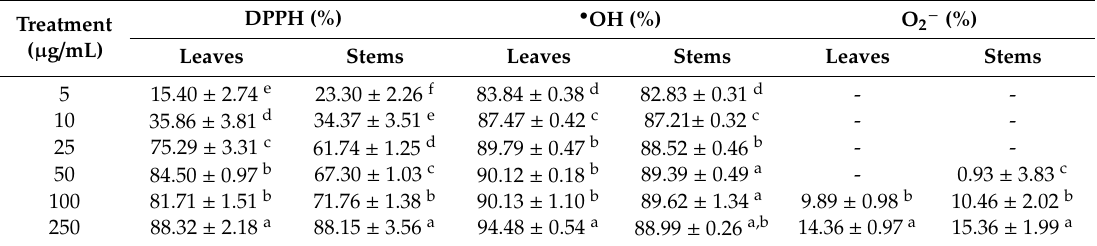
Table 1. DPPH, • OH, and O 2 − radical scavenging activities of A . distichum leaf and stem EtOH extracts.